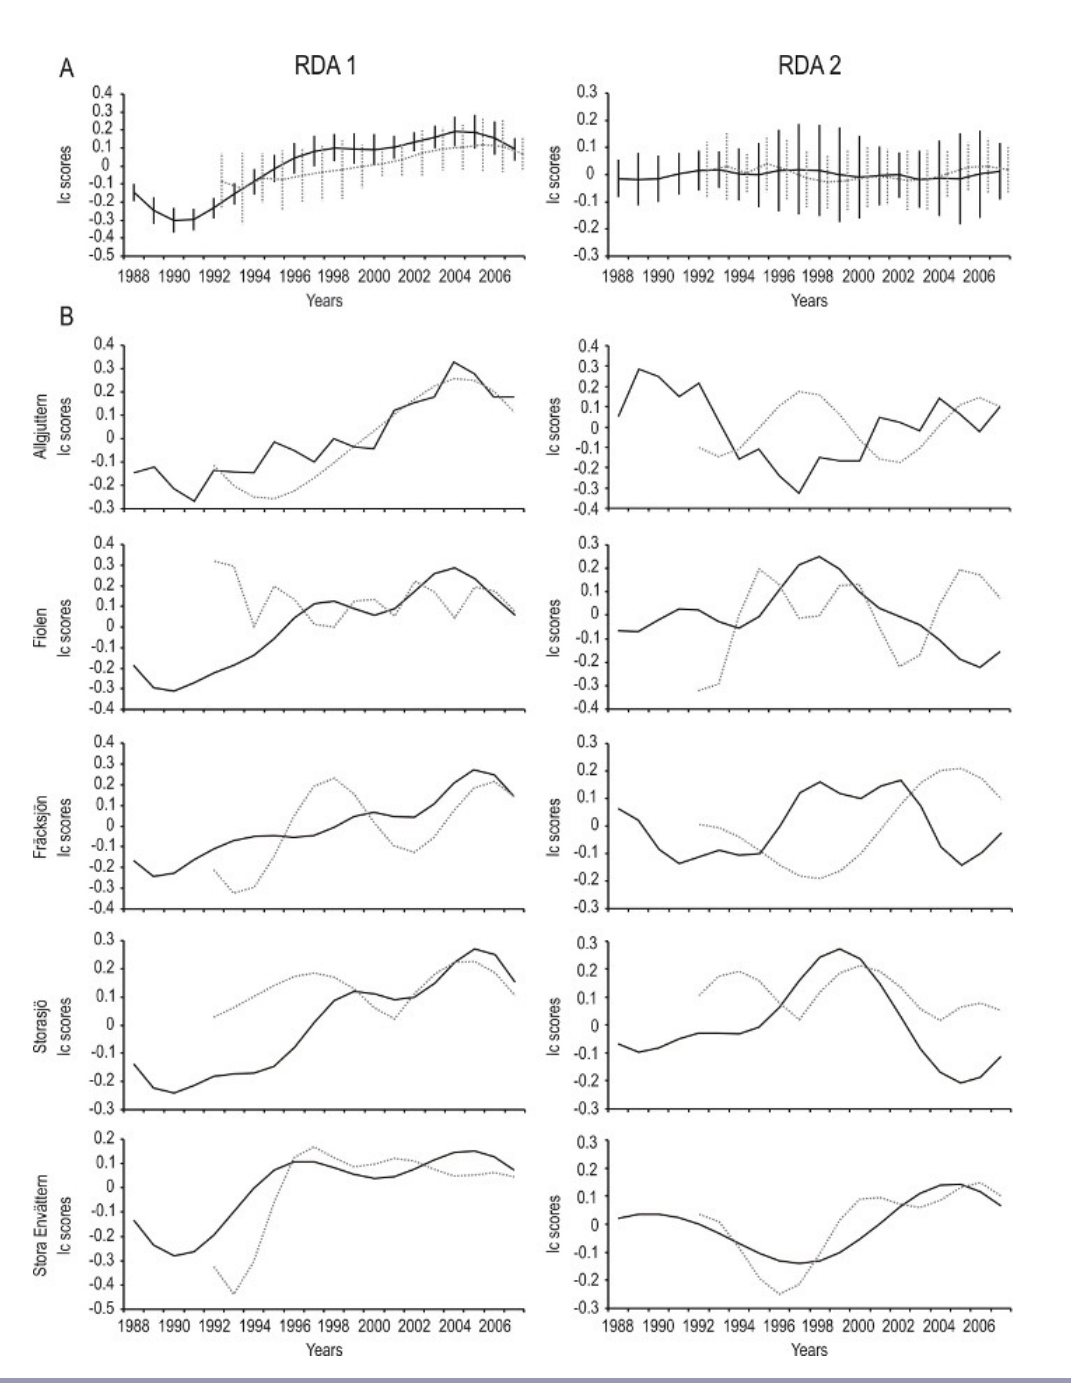
Fig. 1 . Temporal trends of species groups associated with redundancy analysis (RDA) axes 1 and 2 for invertebrates (1988–2007, full black lines) and phytoplankton (1992–2007, dotted grey lines) indicated by linear combination (lc) score plots. Shown are the overall trends (means ± standard deviations) from lakes with significant temporal structure (n = 26, invertebrates; n = 19, phytoplankton) (A), and the trends in selected lakes